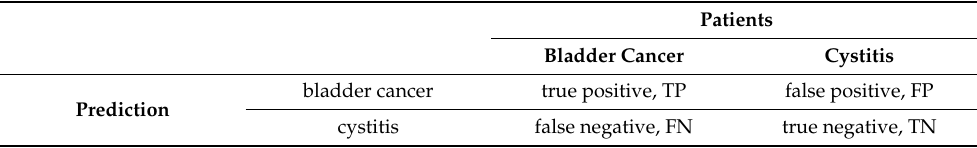
Table 3. The confusion matrix for evaluation of model performance.